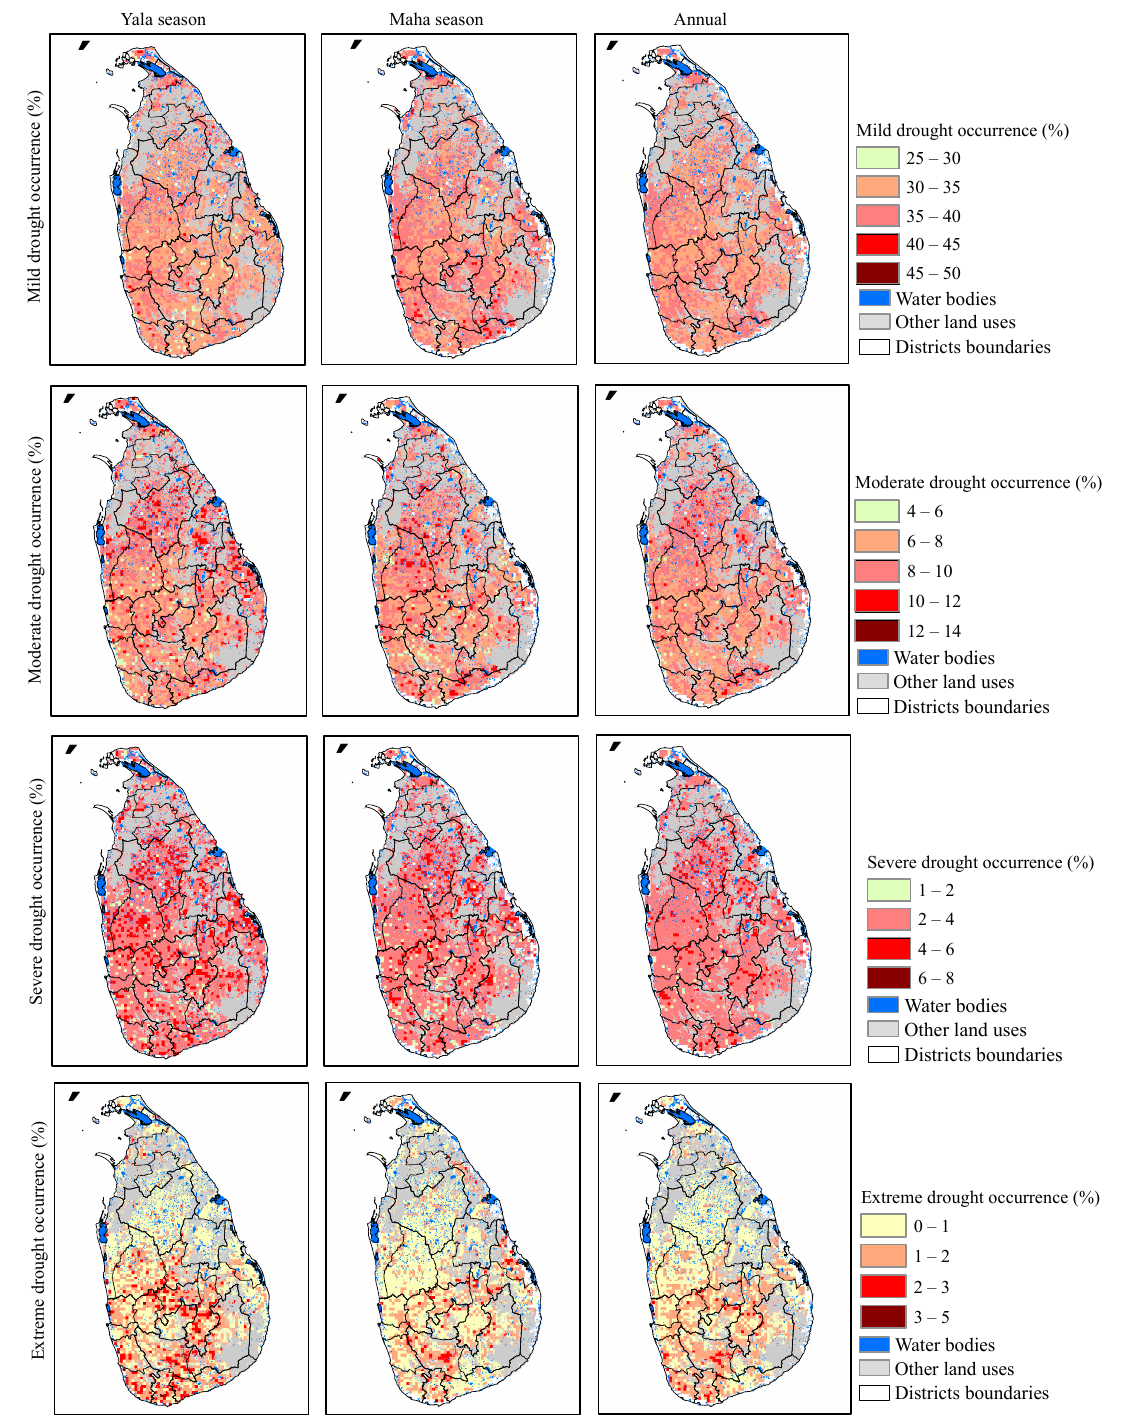
Figure 7. Frequency of occurrence of mild, moderate, severe, and extreme droughts in Yala, Maha and annual.